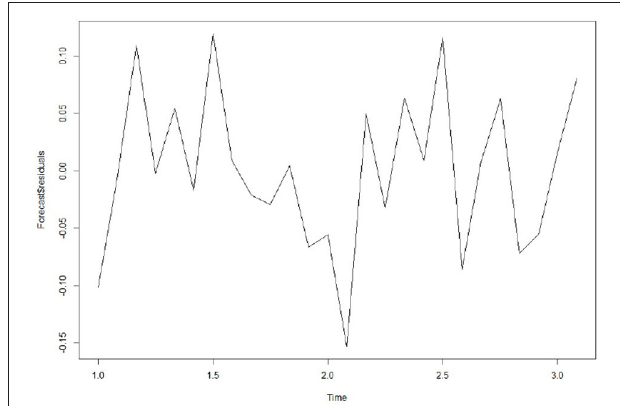
FIGURE 7 | Prediction residual diagram.